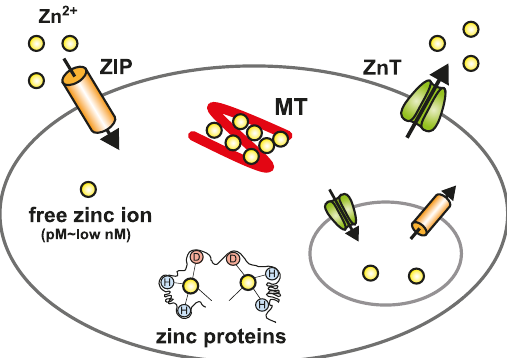
Figure 1. Cellular zinc homeostasis is controlled by the cooperative function of metallothioneins (MT) and Zrt- and Irt-like proteins (ZIP) and Zn transporters (ZnT). The mobilization of zinc into or